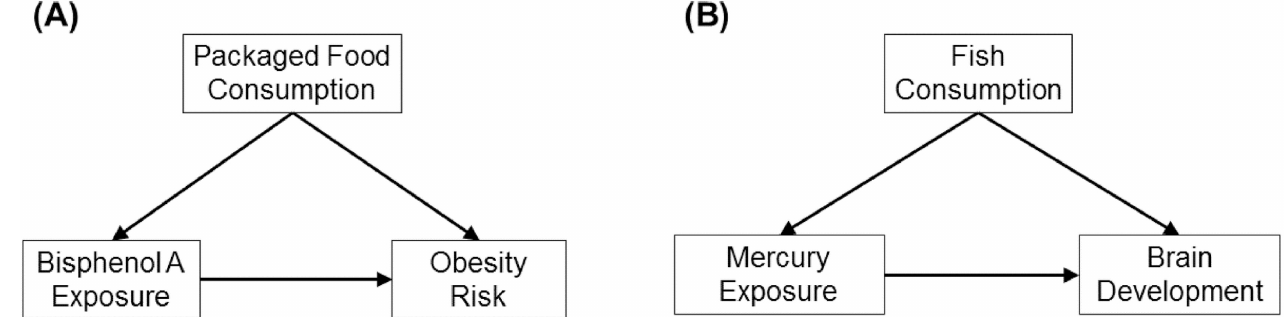
Fig 2. Hypothetical relationsbetween(A) bisphenolA exposure, packagedfood consumption, and obesity risk and (B) prenatalmercury exposure, fish consumption,and brain development. In panel A, a study is investigating whetherbisphenol A is associatedwith increasedrisk of obesity and packagedfood intake is associated with greater bisphenol A exposure and higher obesity risk. This is an exampleof positive confounding, where adjustingfor packagedfood consumption will cause the associationbetweenbisphenol A exposure and obesity to become weaker. In Panel B, we are investigating whethermercury exposureis associatedwith adversebrain development and fish consumption is associatedwith greater mercury exposureand better brain development. This is an example of negative confounding, and adjustingfor fish consumption will make the association betweenmercury exposureand brain development